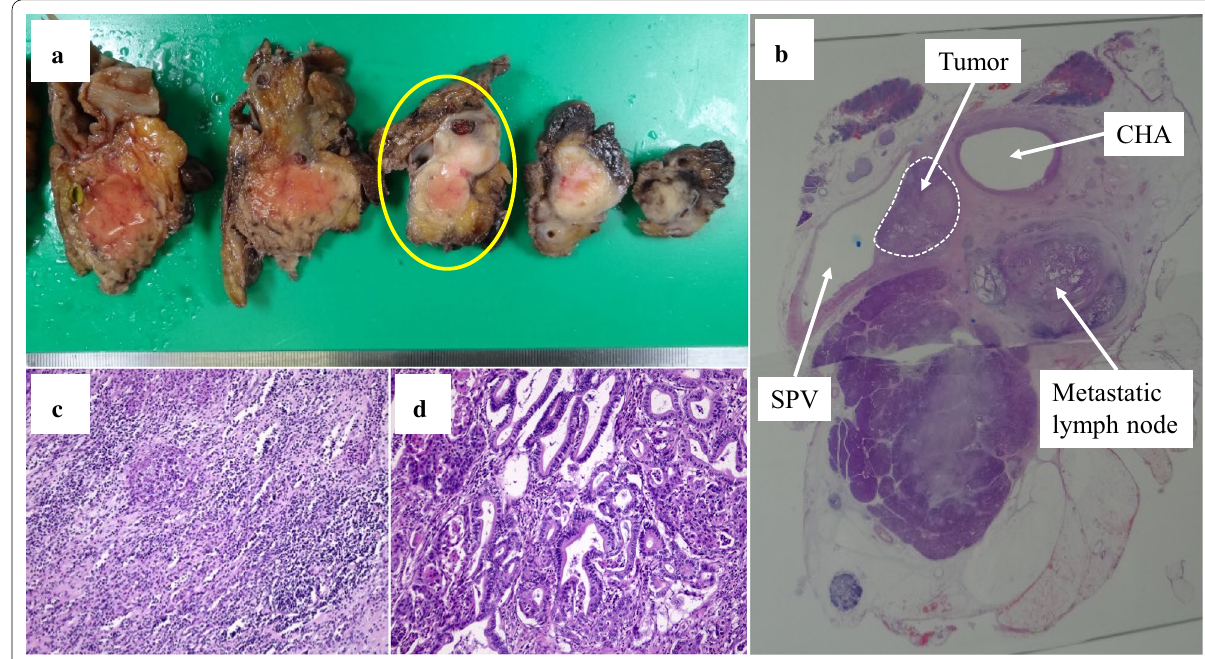
Fig. 5 Pathological findings. a Macroscopic findings of the resected specimen. b Image of the yellow circled section in a as visualized with a loupe. c Area of the tumor in which the chemotherapy effects can be observed (H&E, observed (H&E, 100). CHA common hepatic artery, SPV splenic ×